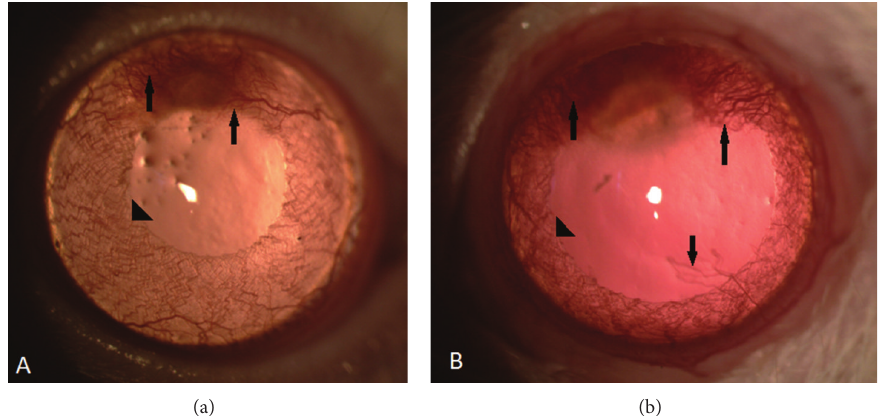
Figure 1: Biomicroscopic corneal findings of the cornea 7 days after induction of corneal burn in eyes. Arrows describe corneal neovascularizations; arrowheads describe the vessels of albino-rat iris. (a) An example of tigecycline-treated eyes. Presence of fewer vessels on the cornea than in control group. (b) An example of control eyes.